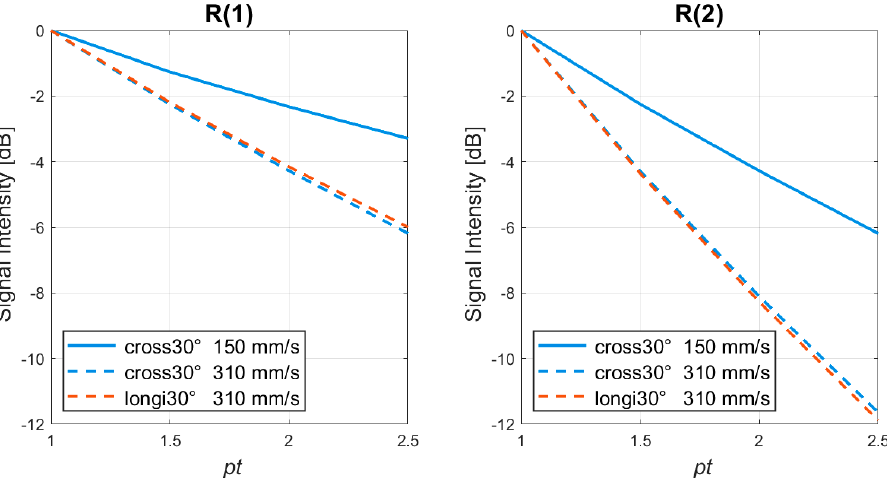
Figure 5. Simulated R(1) and R(2) signal intensity of the blood flow as a function of the pt value in TMAS power Doppler detection. The inclined angle of the flow vessel is 30°.